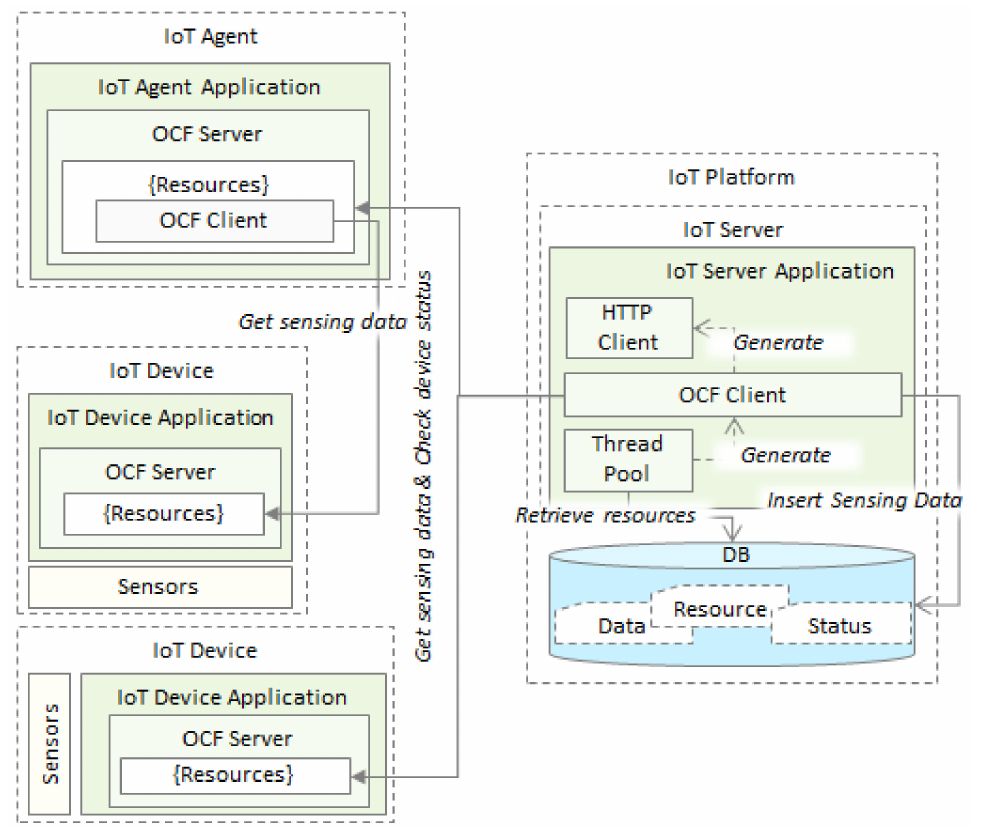
Figure 9. Real-time IoT resource access for status